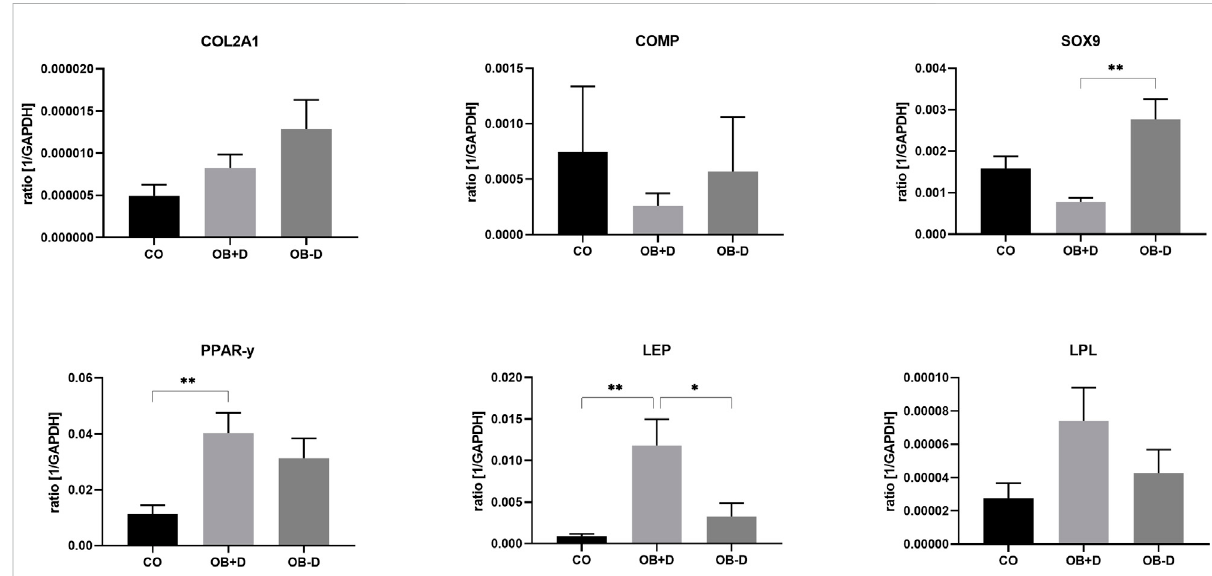
FIGURE 4 Expression of chondrogenic marker genes (upper panel) and adipogenic marker genes (lower panel) by JPCs cultured for 15 days with control medium (CO) and osteogenic medium with (OB+D) and without (OB − D) dexa. Mean ± SEM values of mRNA copy numbers normalized by the housekeeping gene (GAPDH) were calculated and compared using one-way ANOVA and Tukey ’ s multiple comparison test (n = 7, * = p < 0.05, ** = p < 0.01).